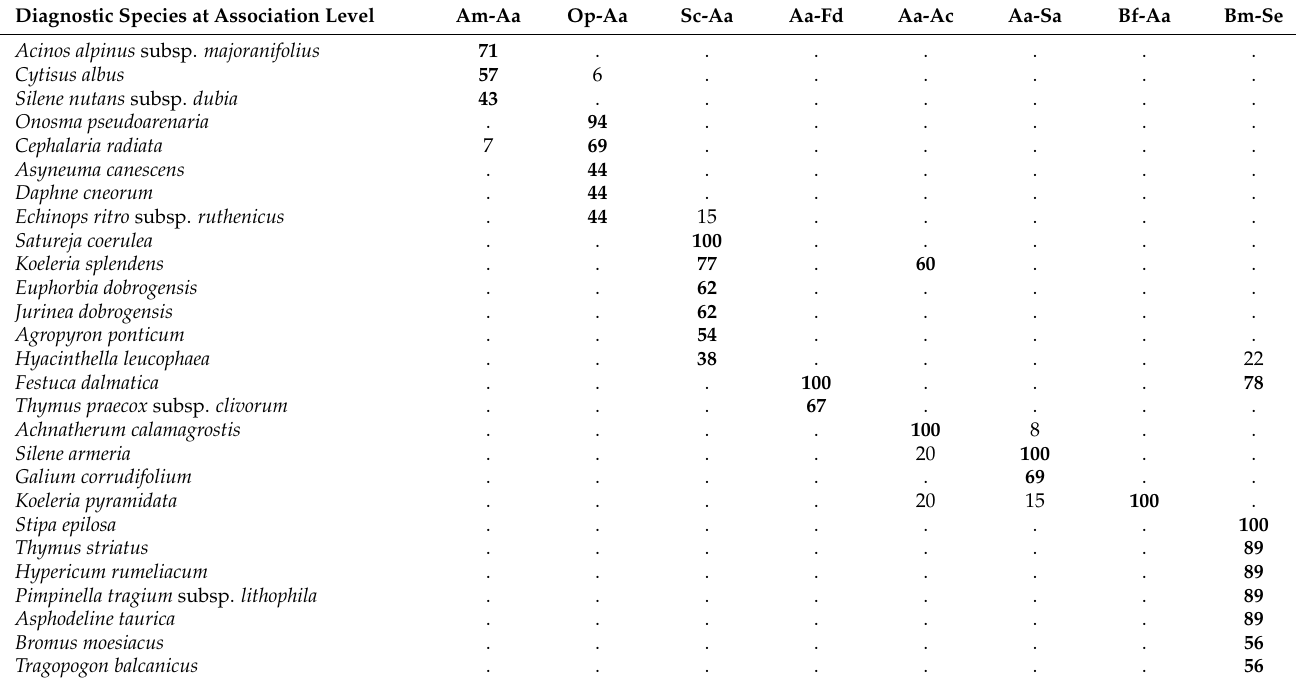
Table 6. Reduced synoptic table including the percentage frequencies (%) of diagnostic species only, for each of the eight syntaxa distinguished. The values in bold are retained as high enough to distinguish between the community types. Abbreviations as in Figure